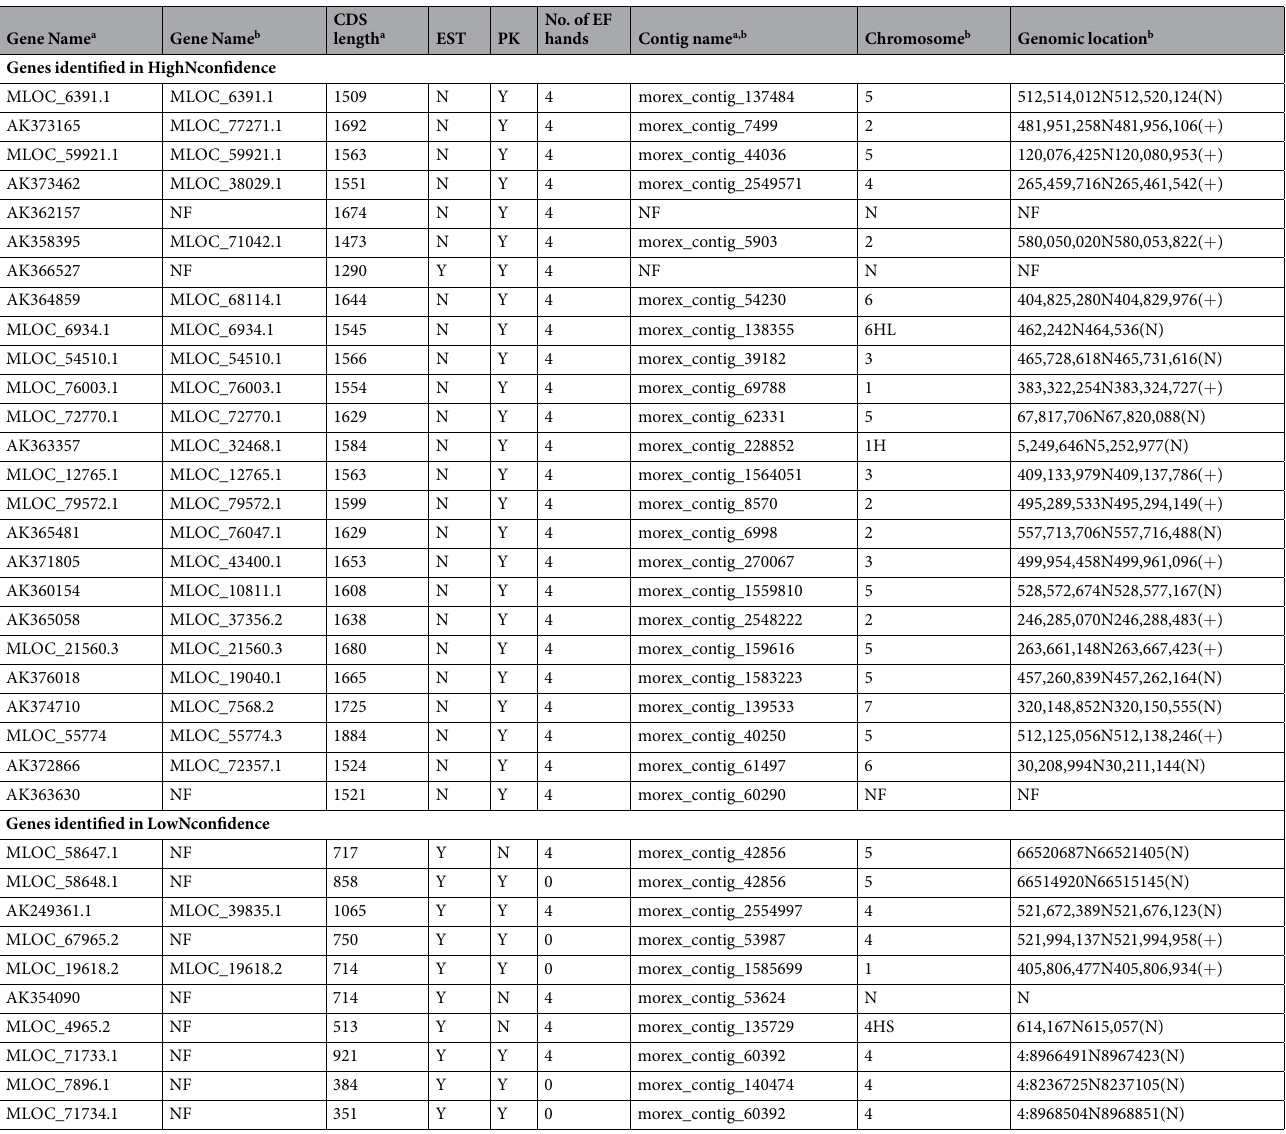
Table 1. Summary information on CDPK genes from barley databases. NF, Not found; N, NO; Y, Yes. a PGSB- PlantsDB database (ftp://ftpmips.helmholtzmuenchen.de/plants/barley/public_data/). b Hordeum vulgare